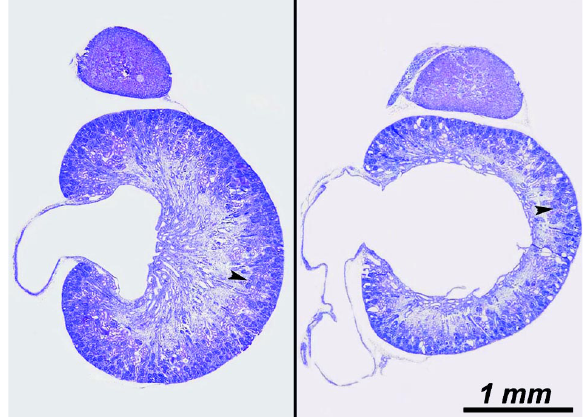
Figure 3 – Microscopic comparison between a normal kidney from the control group (left) with hydronephrotic kidney from the hydronephrosis group (right). The cortical-medullar limit is shown (arrowheads). Note the atrophy in the hydronephrosis group, (HE, X20).